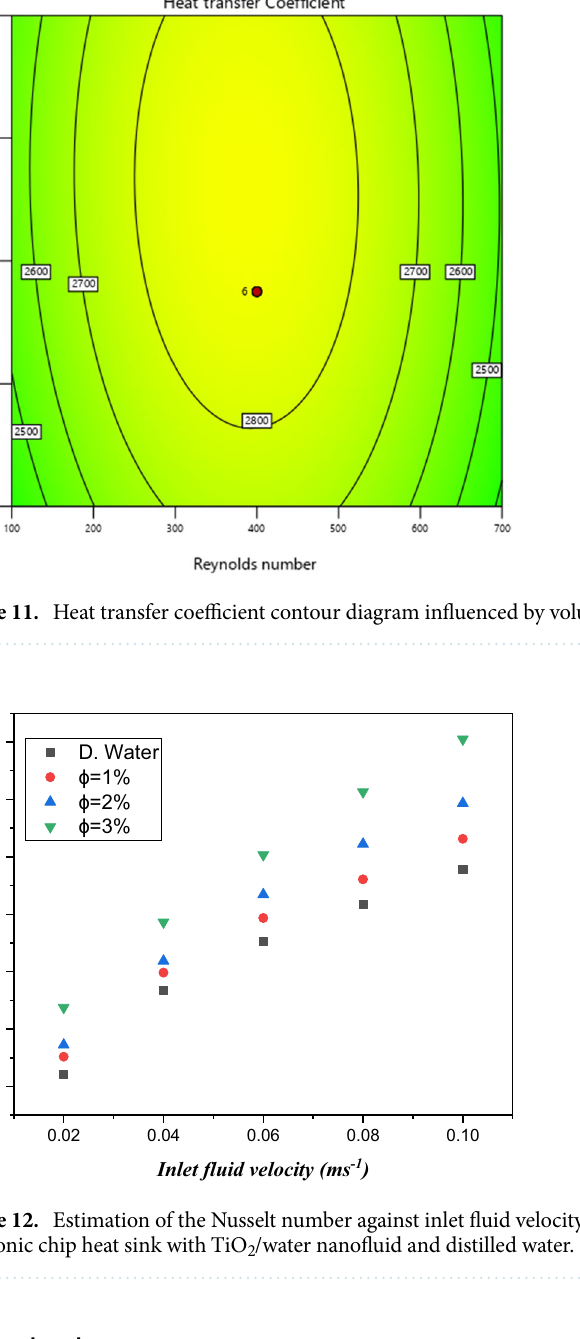
Thermal resistance. Figure 16 demonstrates the thermal resistance values for dissimilar values of TiO 2 /water nanofluid volume fractions versus Reynolds number. Larger values of Reynolds cause a reduction in thermal resistance due to volume friction ( φ = 1% , φ = 2% and φ = 3% ) of the nanofluid. It can be observed that φ = 3% TiO 2 /water nanofluid volume friction demonstrated 16.25% less thermal resistance than water. Physically, the reduction thermal resistance is due to the significantly greater velocity when the Reynolds num- ber is larger. The larger velocity of fluid depresses the thermal resistance among the fluid particles, and larger nanofluids have more heat proficiency. This leads to increased thermal transport, which is inversely proportional to convective thermal resistance. Friction factor. Figure 17 elucidates the friction factor of nanofluid aspects for TiO 2 /water nanofluid vol- ume friction ( φ = 1% , φ = 2% and φ = 3% ) via the Reynolds number. The friction factor of the nanoliquid in the microelectronic six-channel heat sink is reduced by enhancing the Reynolds number. Physically, due to the larger Reynolds number, the velocity is boosted, and the velocity has an opposite relation with the friction factor; therefore, the friction factor of the nanofluid declines with a greater Reynolds number.